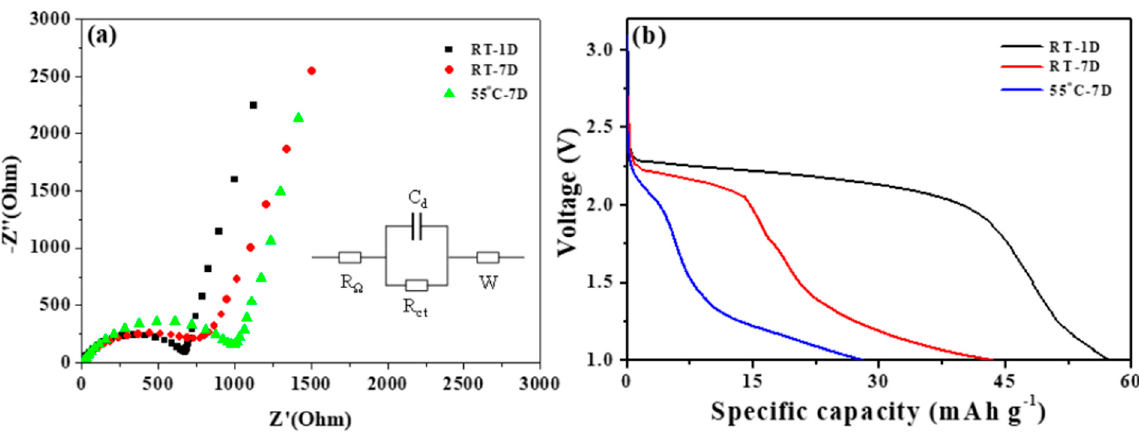
Figure 3. The EIS curves before the discharge test ( a ) and the discharge curves ( b ) of the RT-1D, RT-7D and 55 °C-7D batteries. The inset in ( a ) is the corresponding equivalent circuit.